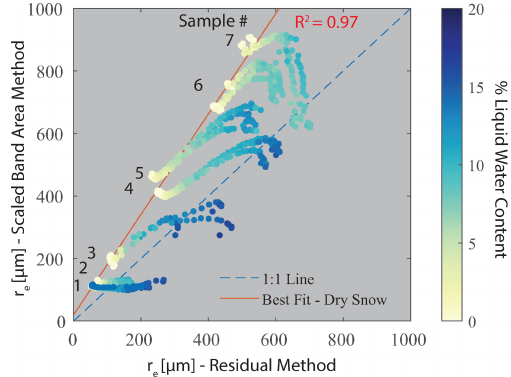
Figure 10. Mean effective grain radius ( r e ) retrieval comparison between residual and scaled band area methods using the interstitial sphere model at each time step for Samples 1–7. Best fit line is drawn through the dry snow condition for each